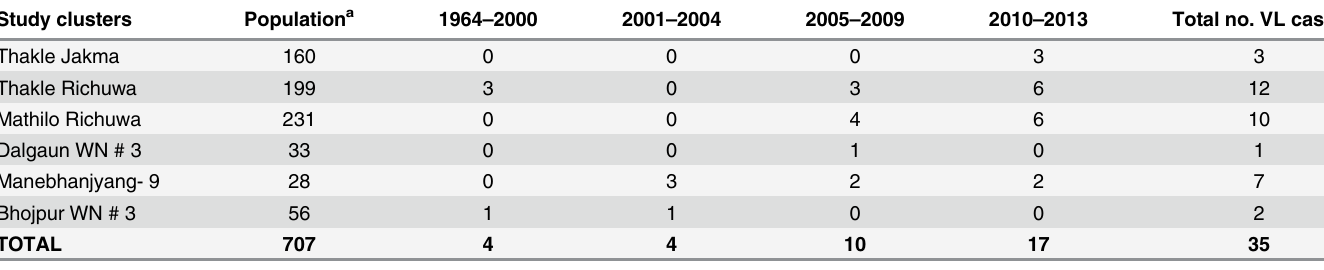
Table 2. Number of VL (KA) cases retrieved in the study clusters over study period. Study clusters